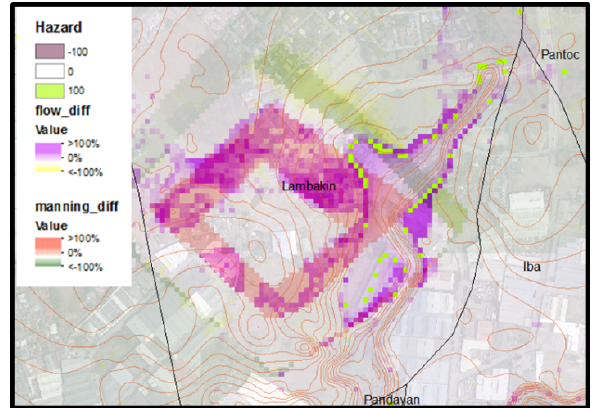
Figure 11. Change in Flooding due to Land Use change in Area 2 3.3.3 Area 3 : Figure 12 is located in the far-flung region of